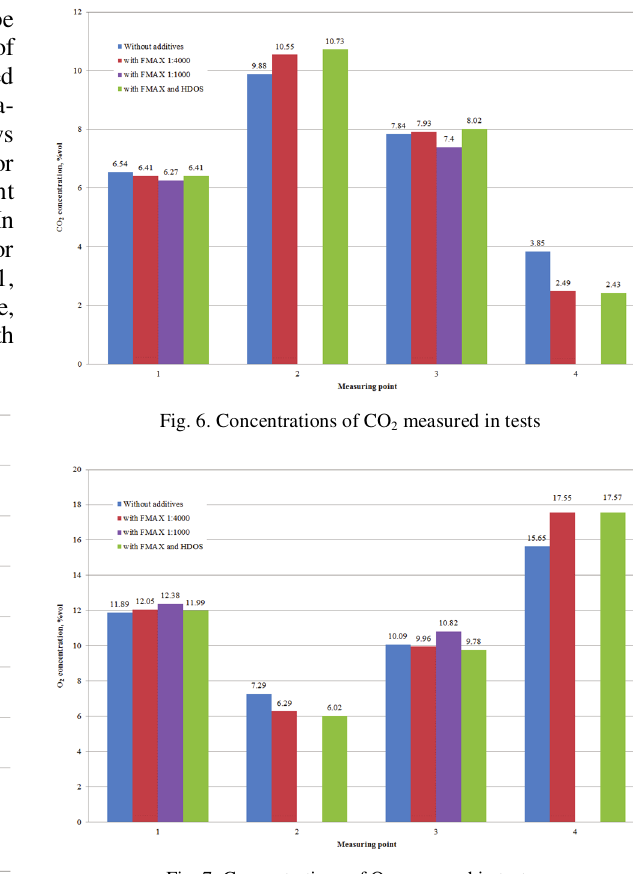
Fig. 7. Concentrations of O 2 measured in